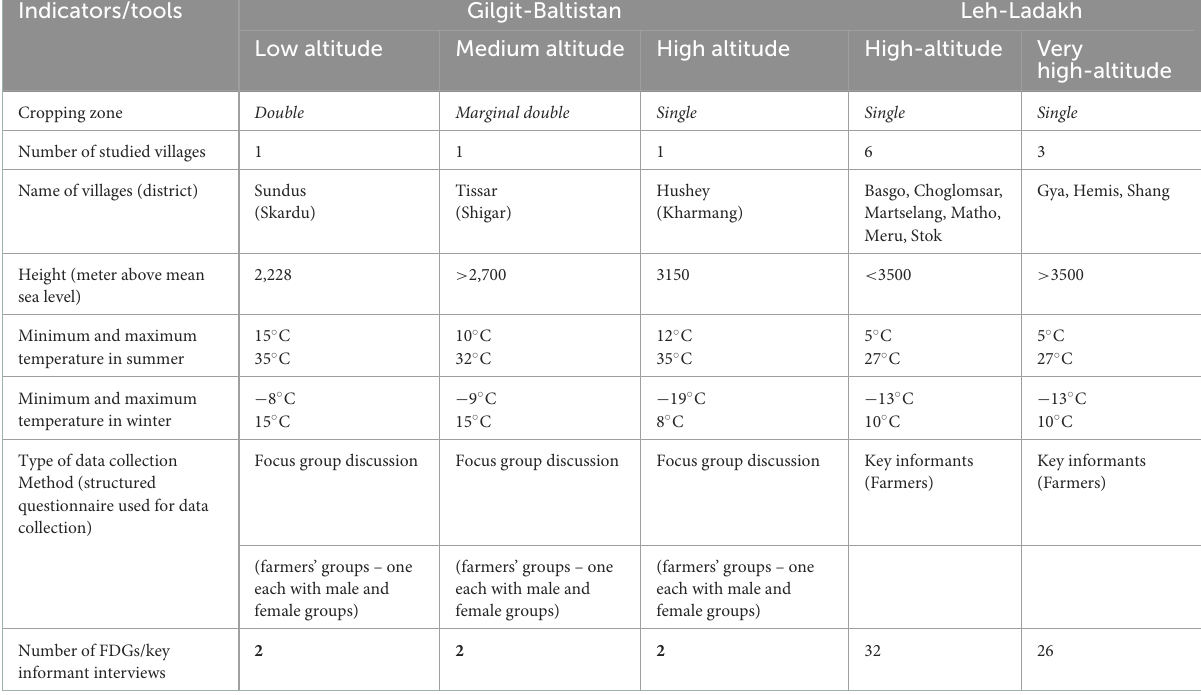
TABLE 1 Study sites and data